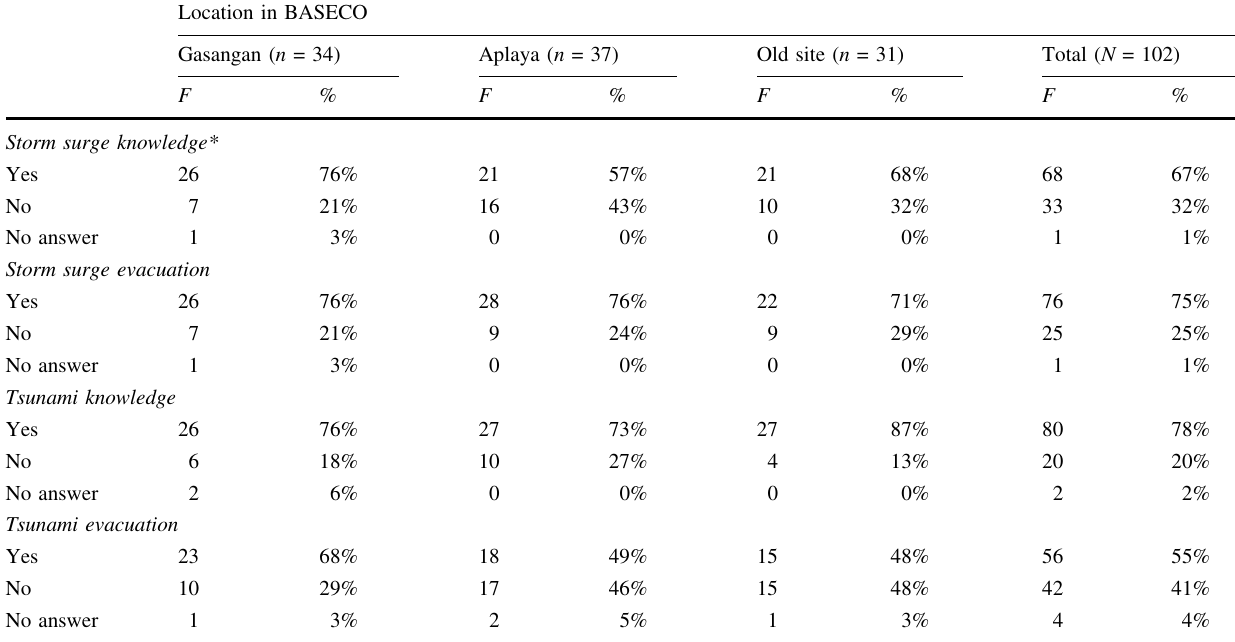
Table 2 Summary of storm surge and tsunami knowledge and evacuation by location within the community ( N = 102) in BASECO Compound in Manila Location in